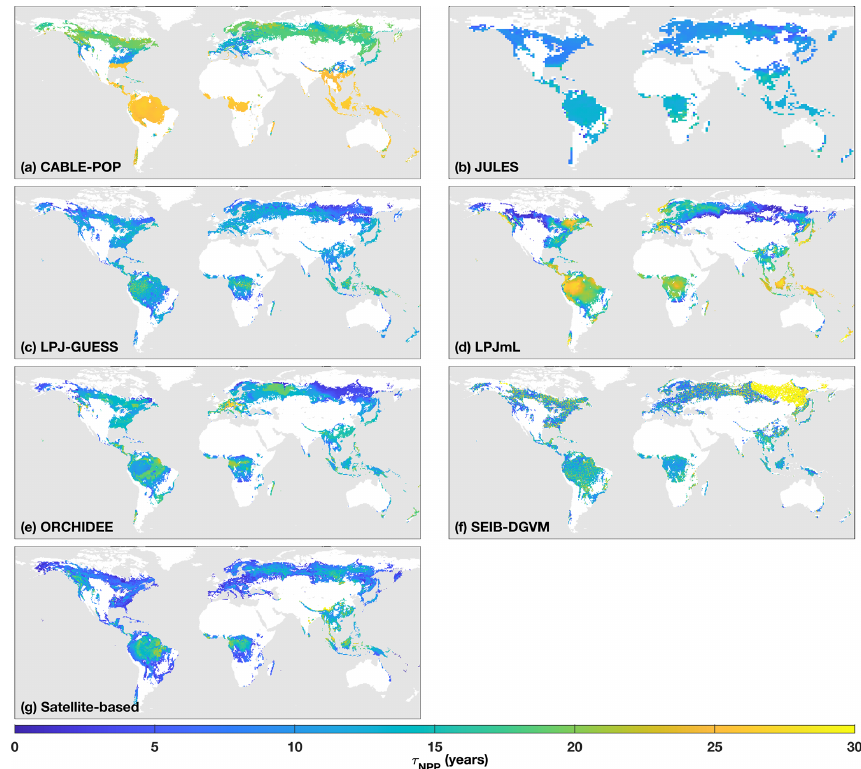
Figure 1. τ NPP mean for the period 1985–2014 as forced by the CRU-NCEP climate (units of years). Colour scale is capped at 30 years. Maps show areas which are simulated as forest for each model and have at least 10% of the grid cell covered by closed-canopy forest based on Hansen et al. (2013; see “Methods”). Table 4. Global closed-canopy forest totals, 1985–2014, based on the CRU-NCEP-forced simulations and satellite-based methods.